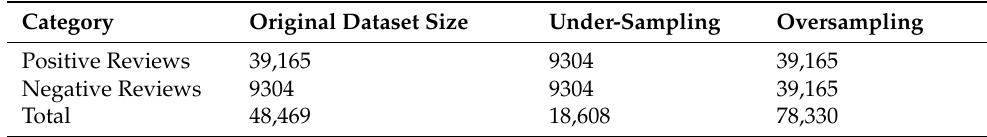
Table 29. Number of samples after applying re-sampling.